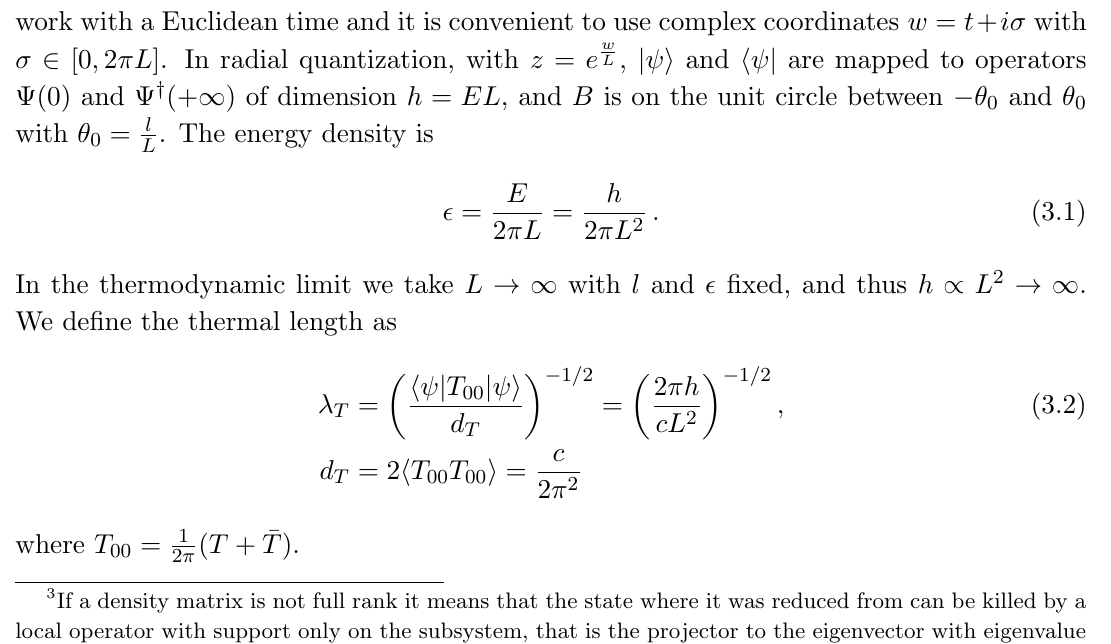
R t conformal frame (b) The radial quantization (cid:2)